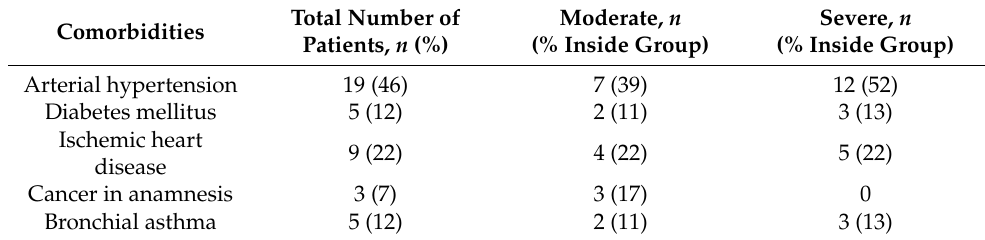
Table 1. Comorbidities of patients with